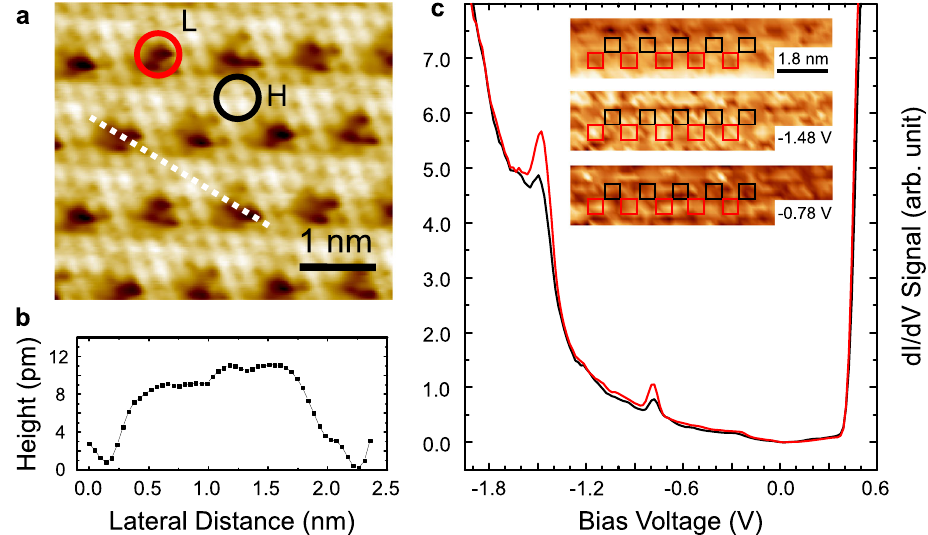
Fig. 3 Moiré high and moiré low regions. a An STM image of the R(37/61) region shown on the left side of Fig. 1 ( V bias = − 0.5 V, I set = 0.5 nA). The black and red circles are label examples of high (H) and low (L) points of the moiré pattern. b The height pro fi le following the dashed white line shows an apparent height corrugation of 12 pm over one period of the moiré pattern. c The STS curves averaged over H and L areas are distinct. The red and black curves were averaged from the corresponding rectangular areas shown in the fi rst inset and each rectangle includes around ten spectra. The second and third insets present the dI/dV conductance mapping at each in-gap peak ’ s energy, − 1.48 and − 0.78 V. (The spectra are zoom-in of Fig.